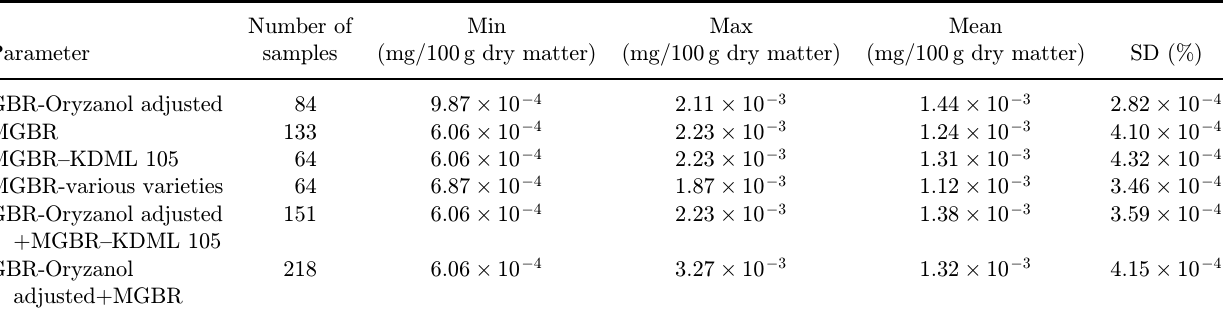
Table 1. Minimum (Min), maximum (Max), mean and SD of gamma oryzanol content of the GBR.